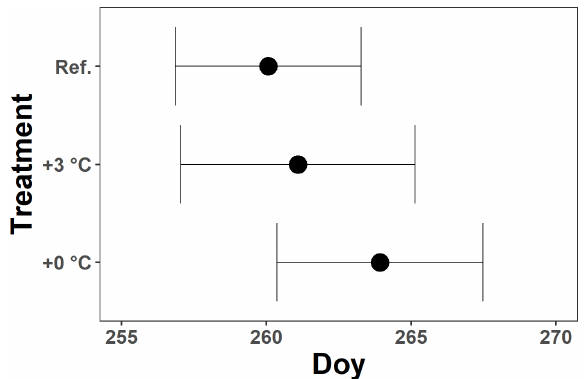
Figure A3. The mean onset of autumn leaf senescence per treatment for all Fagus sylvatica saplings at the Drie Eiken Campus in Wilrijk. Black dots represent the mean onset of autumn leaf senescence, while the error bars represent standard errors that indicate the inter-individual variability. All breakpoints are calculated using the chlorophyll content index data and piecewise linear regressions ( n Ref . = 29; n + 0 ◦ C = 26; n + 3 ◦ C = 22): Ref. represents the breakpoints of the trees in the reference plots, while + 0 and + 3 ◦ C represent the breakpoints of the trees in the glasshouses under the less irrigation or drought and the less irrigation or drought, warming, and increased atmospheric aridity treatments,